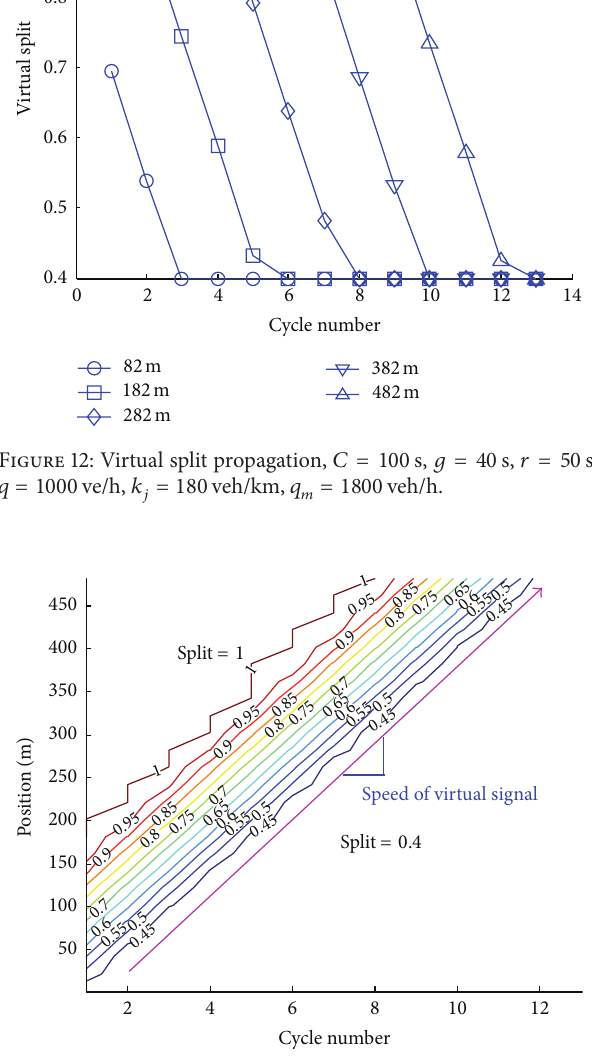
Figure 13: Contour of split on space-time diagram and parameters are the same as in Figure 12.